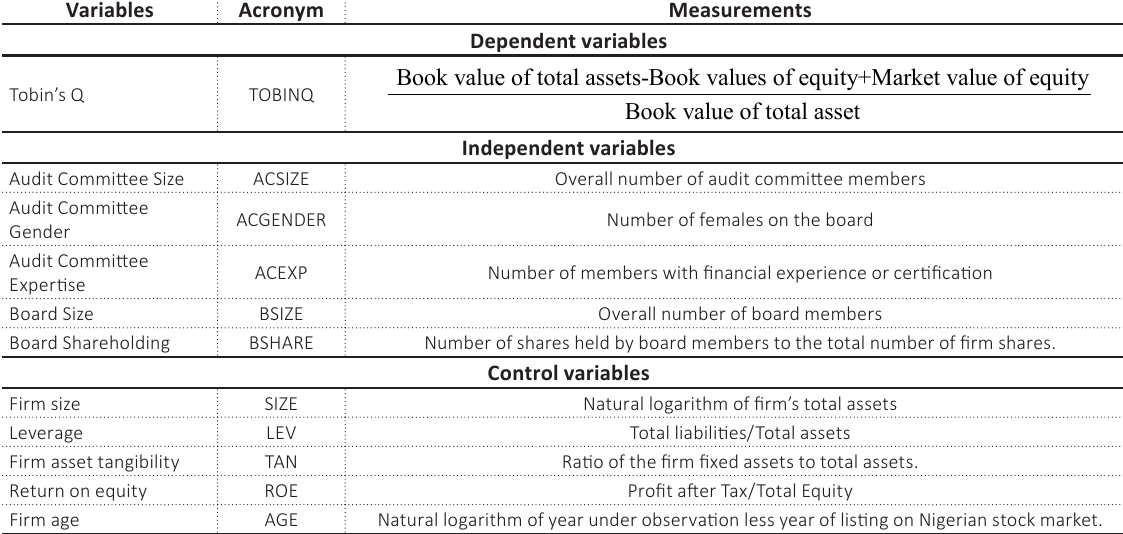
Table 1. Variable